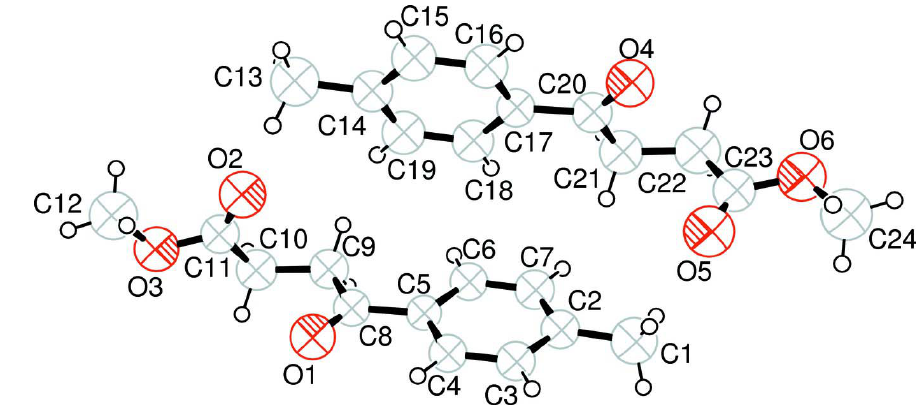
Figure 1 The molecular structure of the title molecule, with the atom-numbering scheme.